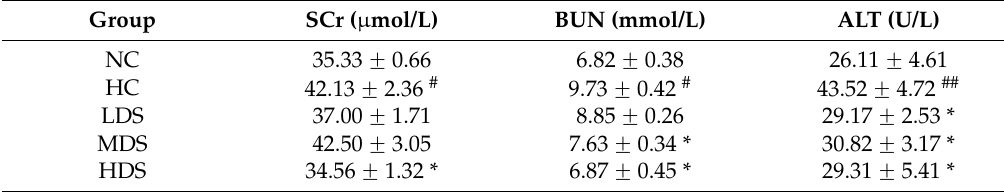
Table 3. BUN, SCr and ALT levels in rats from different groups after 12